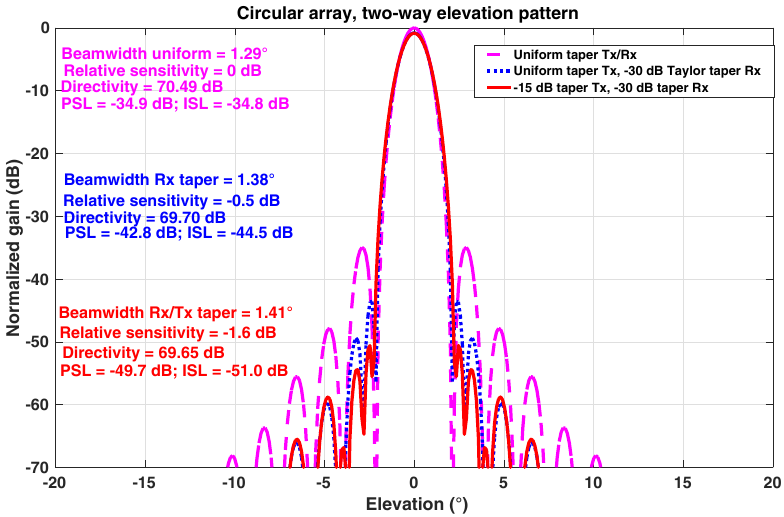
Figure 7. Transmit and receive patterns of the circular aperture for three different tapering: (i) uniform tapering for both transmit and receive, (ii) uniform transmit and 30dB Taylor taper for the receive, and (iii) 15 and 30dB Taylor tapering of transmit and receive